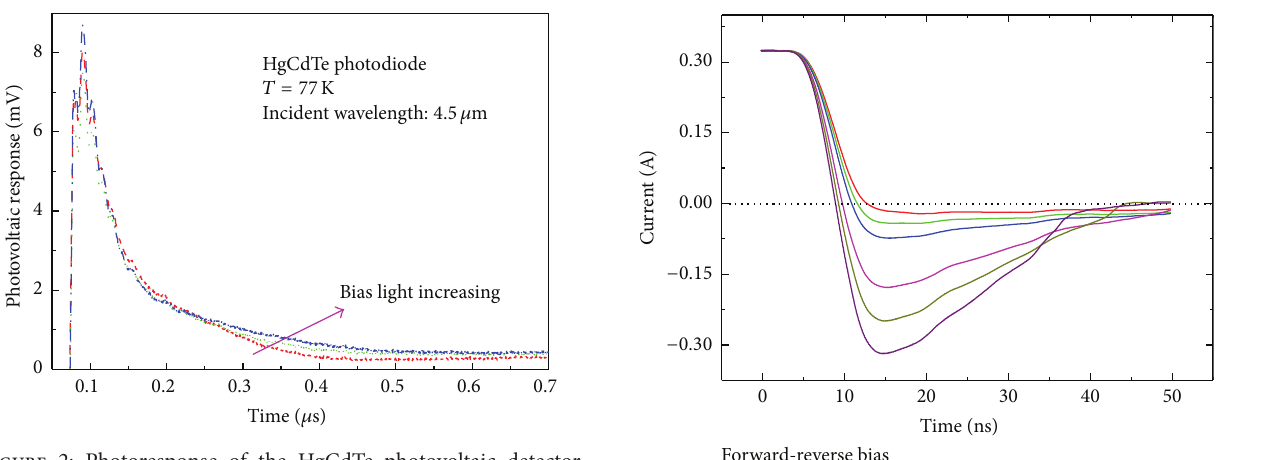
Figure 2: Photoresponse of the HgCdTe photovoltaic detector illuminated by laser pulses with different bias light intensity with a small resistance paralleled in the load circuit.